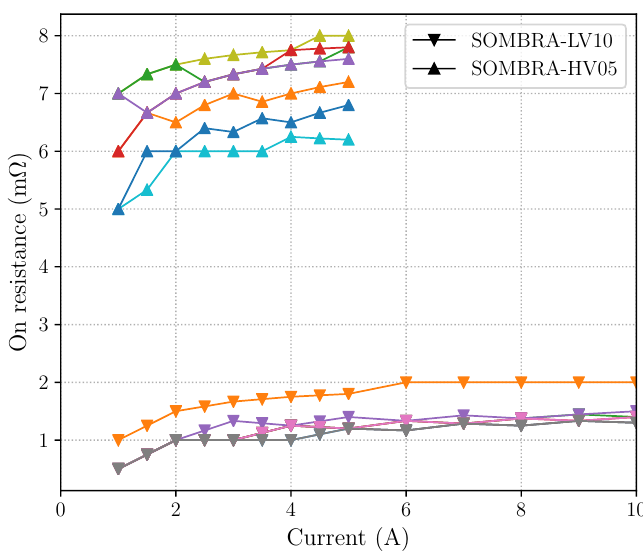
Figure 11. On resistance measurement. The average on resistance is 7.3 m Ω for SOMBRA-HV05 and 1.3 m Ω for SOMBRA-LV10.